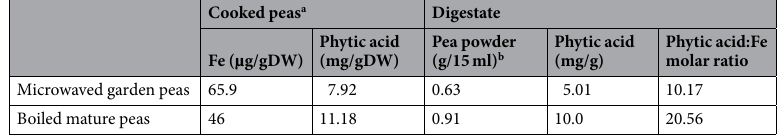
Table 2. Iron and phytic acid concentrations in pea samples. a Lyophilized prior to analysis of iron and phytic acid. b The amount of each sample was adjusted prior to the simulated digestion to achieve a final concentration of 50 µ M iron in the volume of